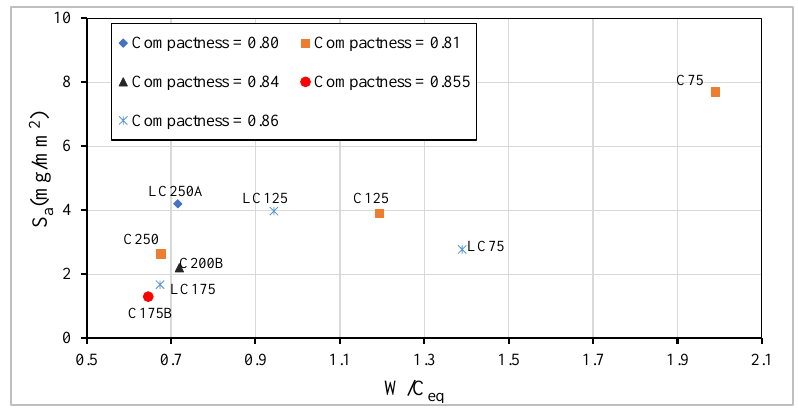
Figure 15. Relation between the capillarity water absorption vs. W/C eq .